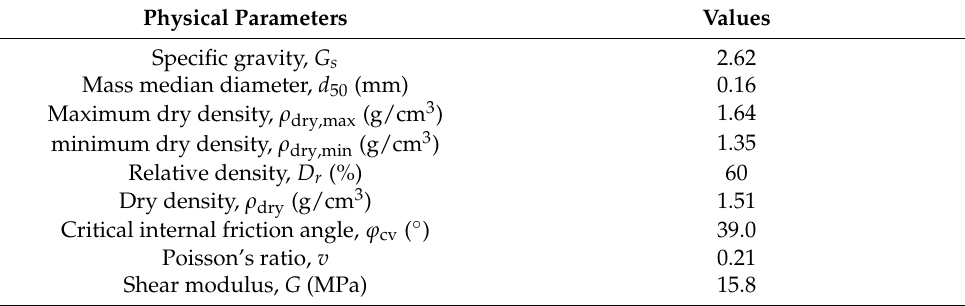
Table 3. Physical properties of the Fujian